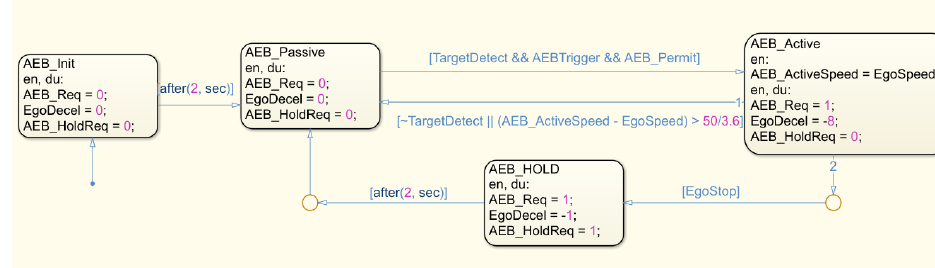
Figure 6. Control logic of AEBS basic functions in Stateflow.